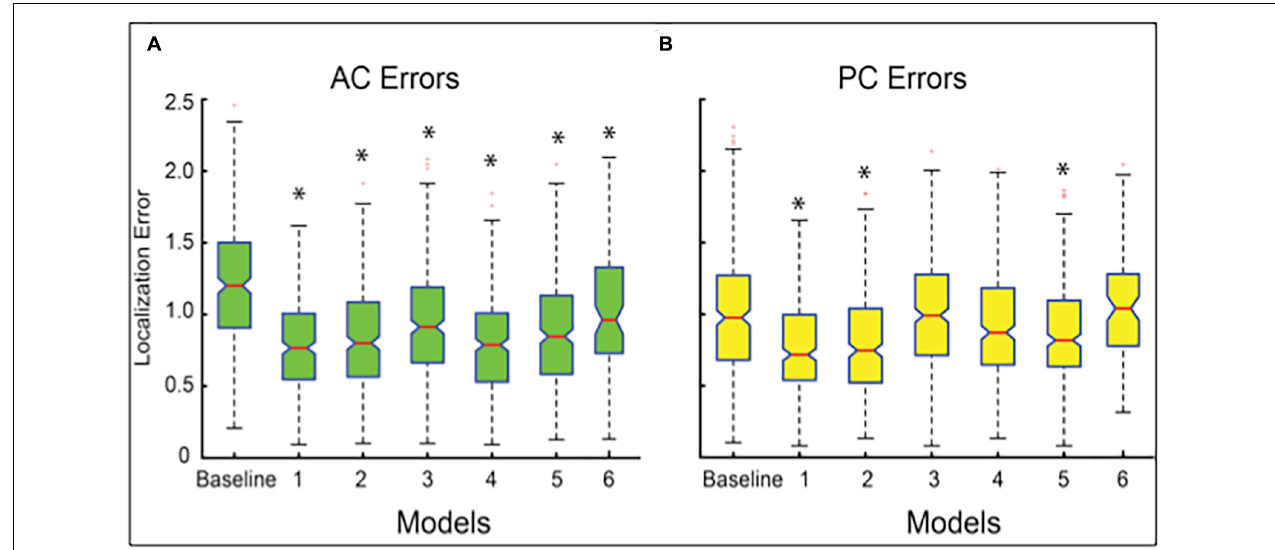
√ n around the median notch for each box. Non-overlapping